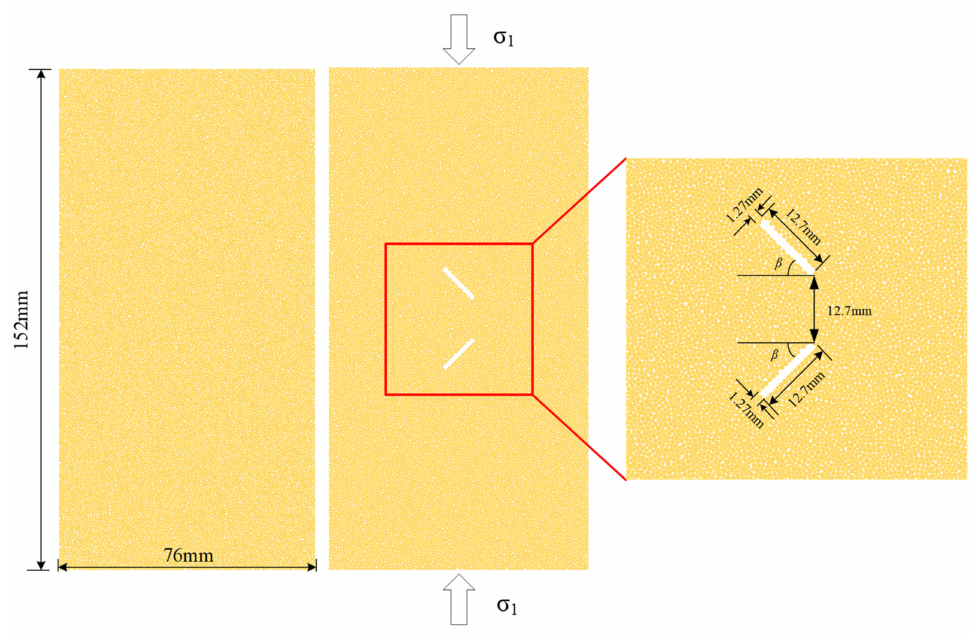
Figure 2. Intact numerical model and a numerical model with non-parallel overlapping flaws.